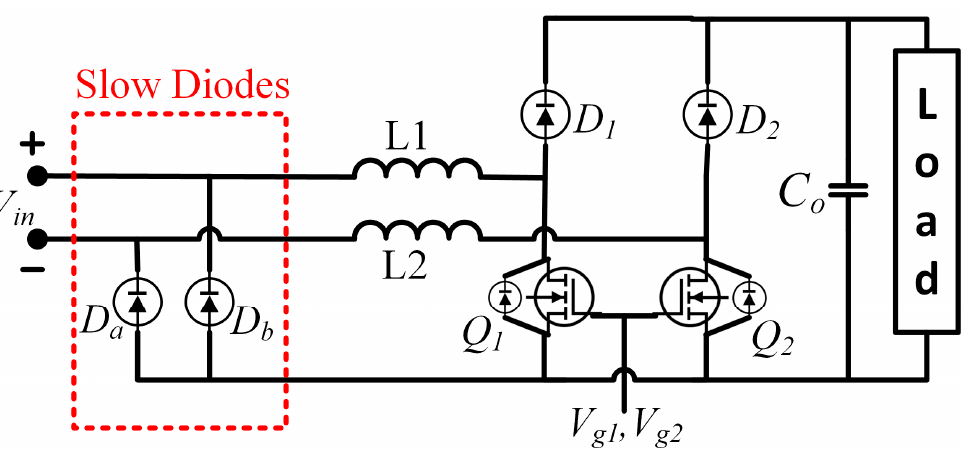
Figure 46. Bridgeless/Dual Boost PFC Converter. Adapted from [46].